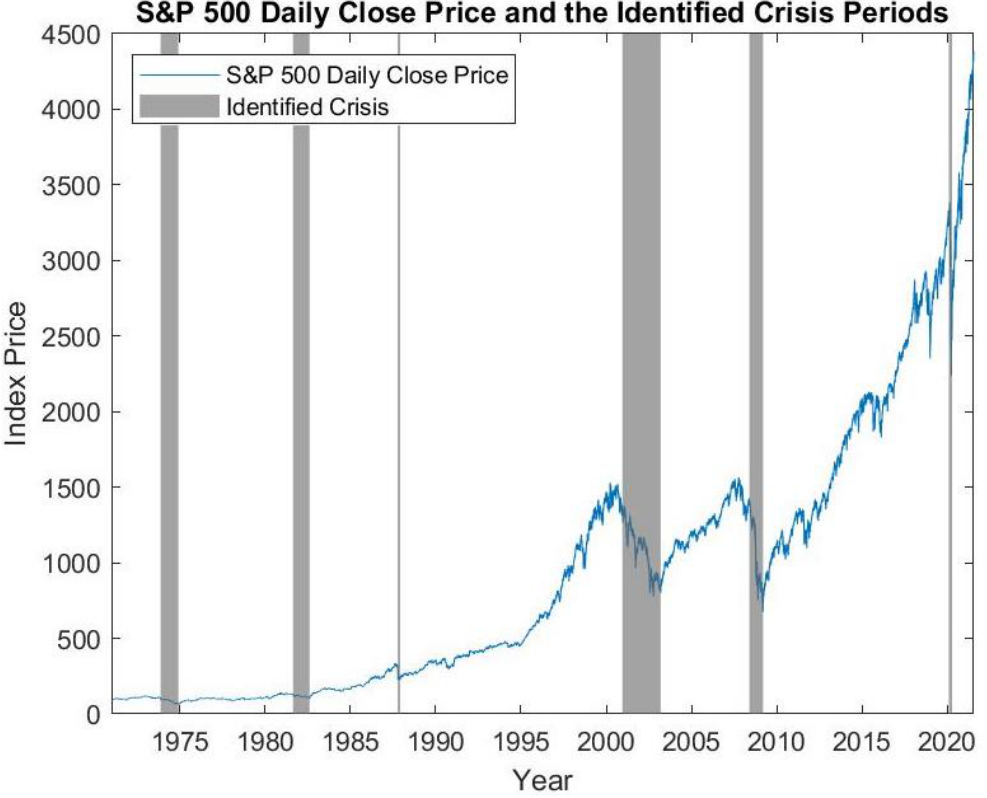
Figure 1. S & P 500 Daily Closing Price and Identified Crisis